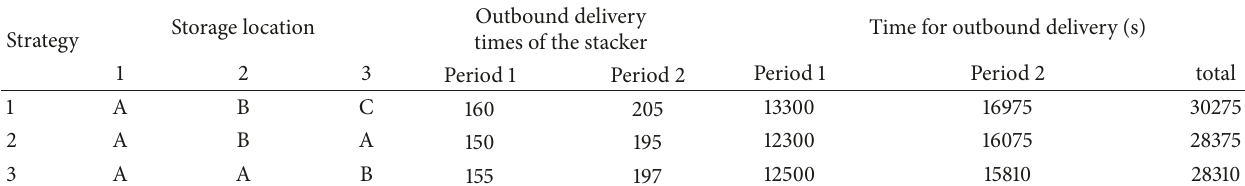
Table 2: Comparison of times for outbound cargo delivery under different storage strategies.